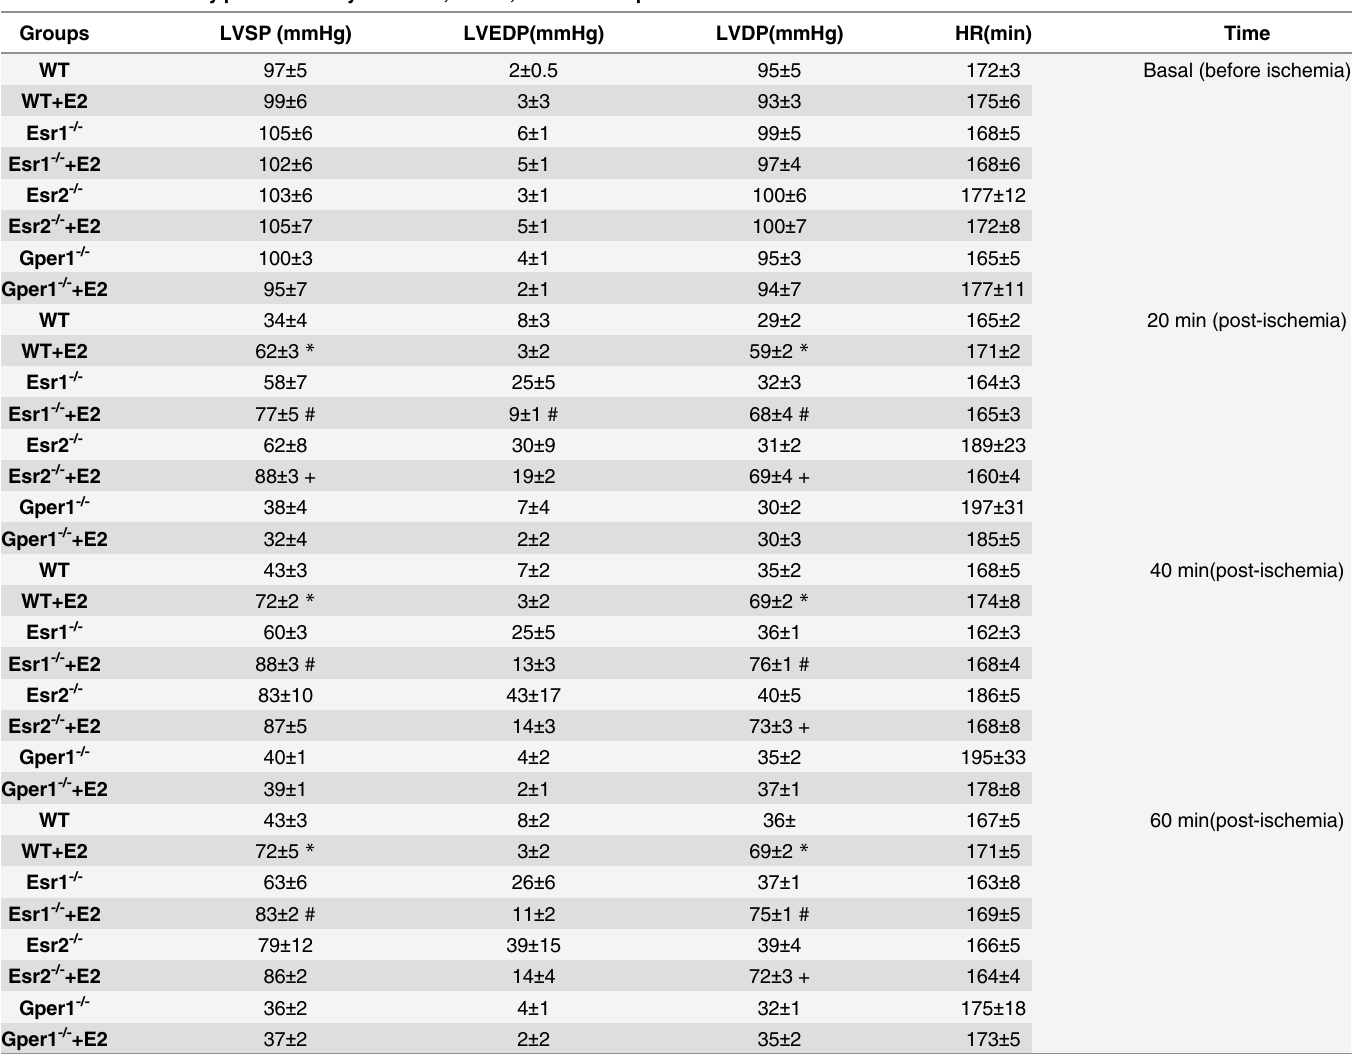
Table 1. Heart recovery parameters by E2 in WT, Esr1 -/- , Esr2 -/- and Gper1 -/- .